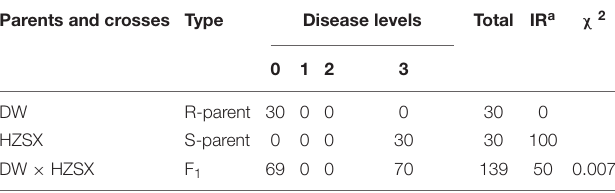
TABLE 1 | Disease phenotype statistics in F 1 population from cross of DW and HZSX. Parents and crosses Type Disease levels Total IR